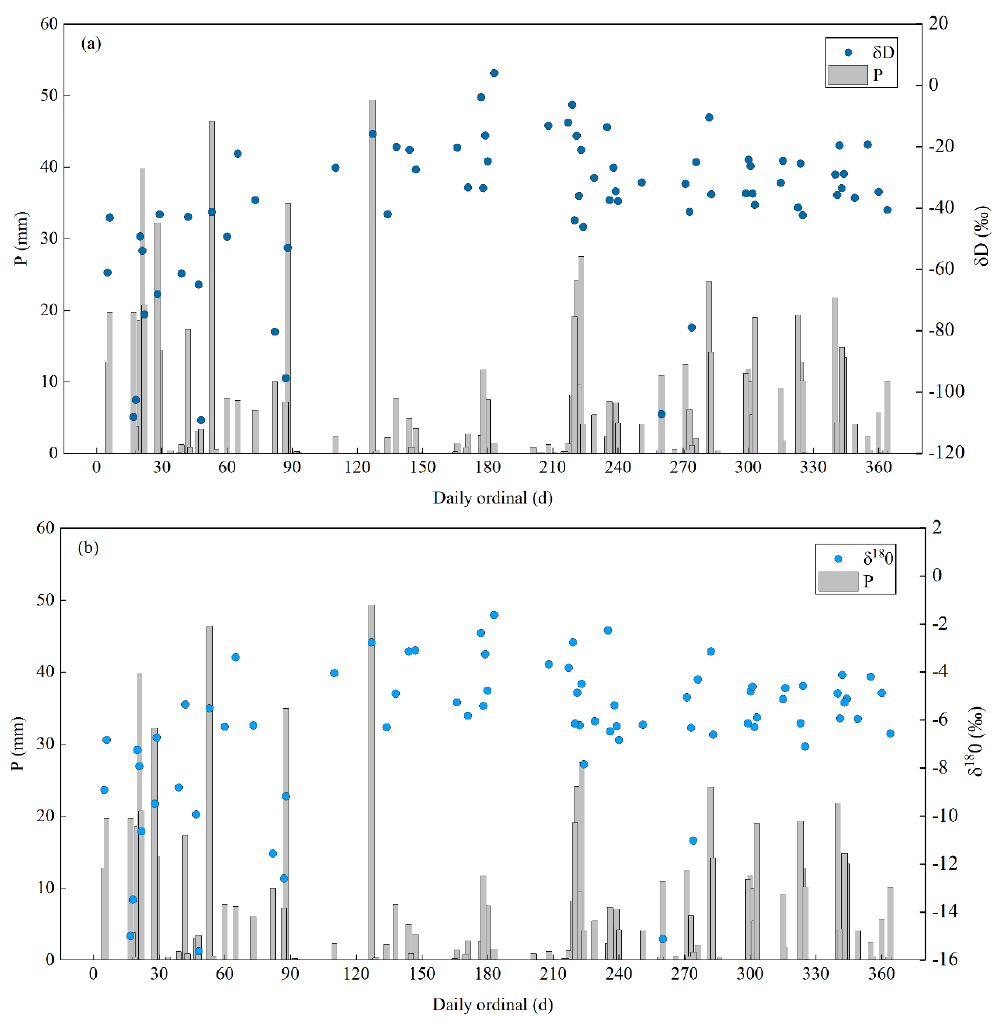
Figure 4. Precipitation and isotopic composition of rainwater during the observation period ( a ) Precipitation and δ D composition of rainwater, ( b ) Precipitation and δ 18 O composition of rainwa- ter. The starting point of the abscissa axis represents 1 June